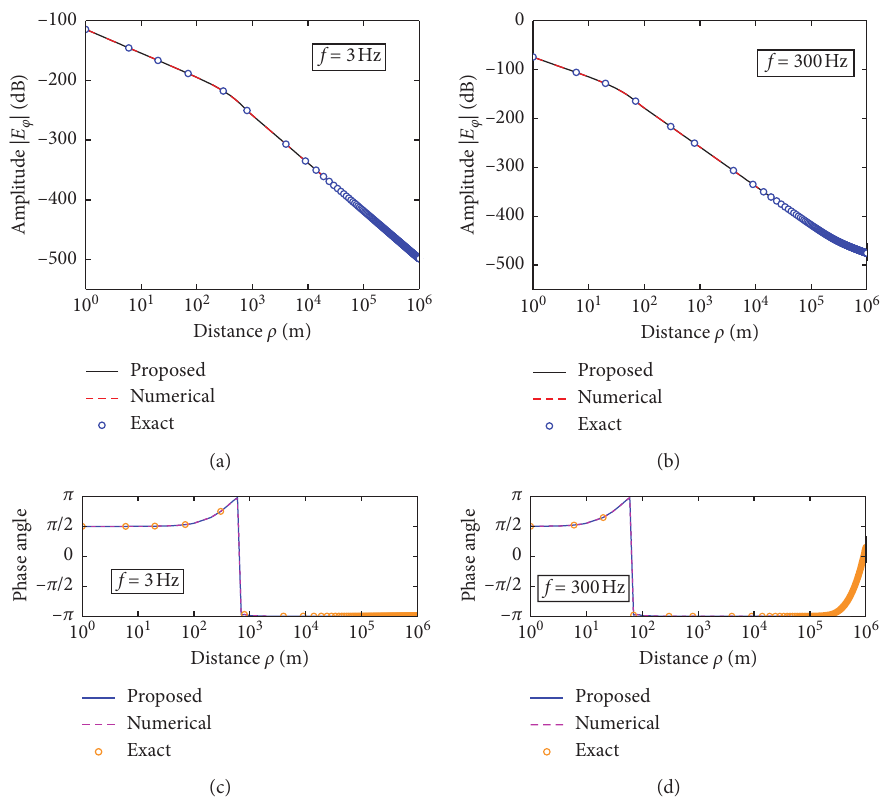
Figure 6: Amplitudes and phase angles of field component E solutions. (a, c) f � 3 Hz. (b, d) f � 300